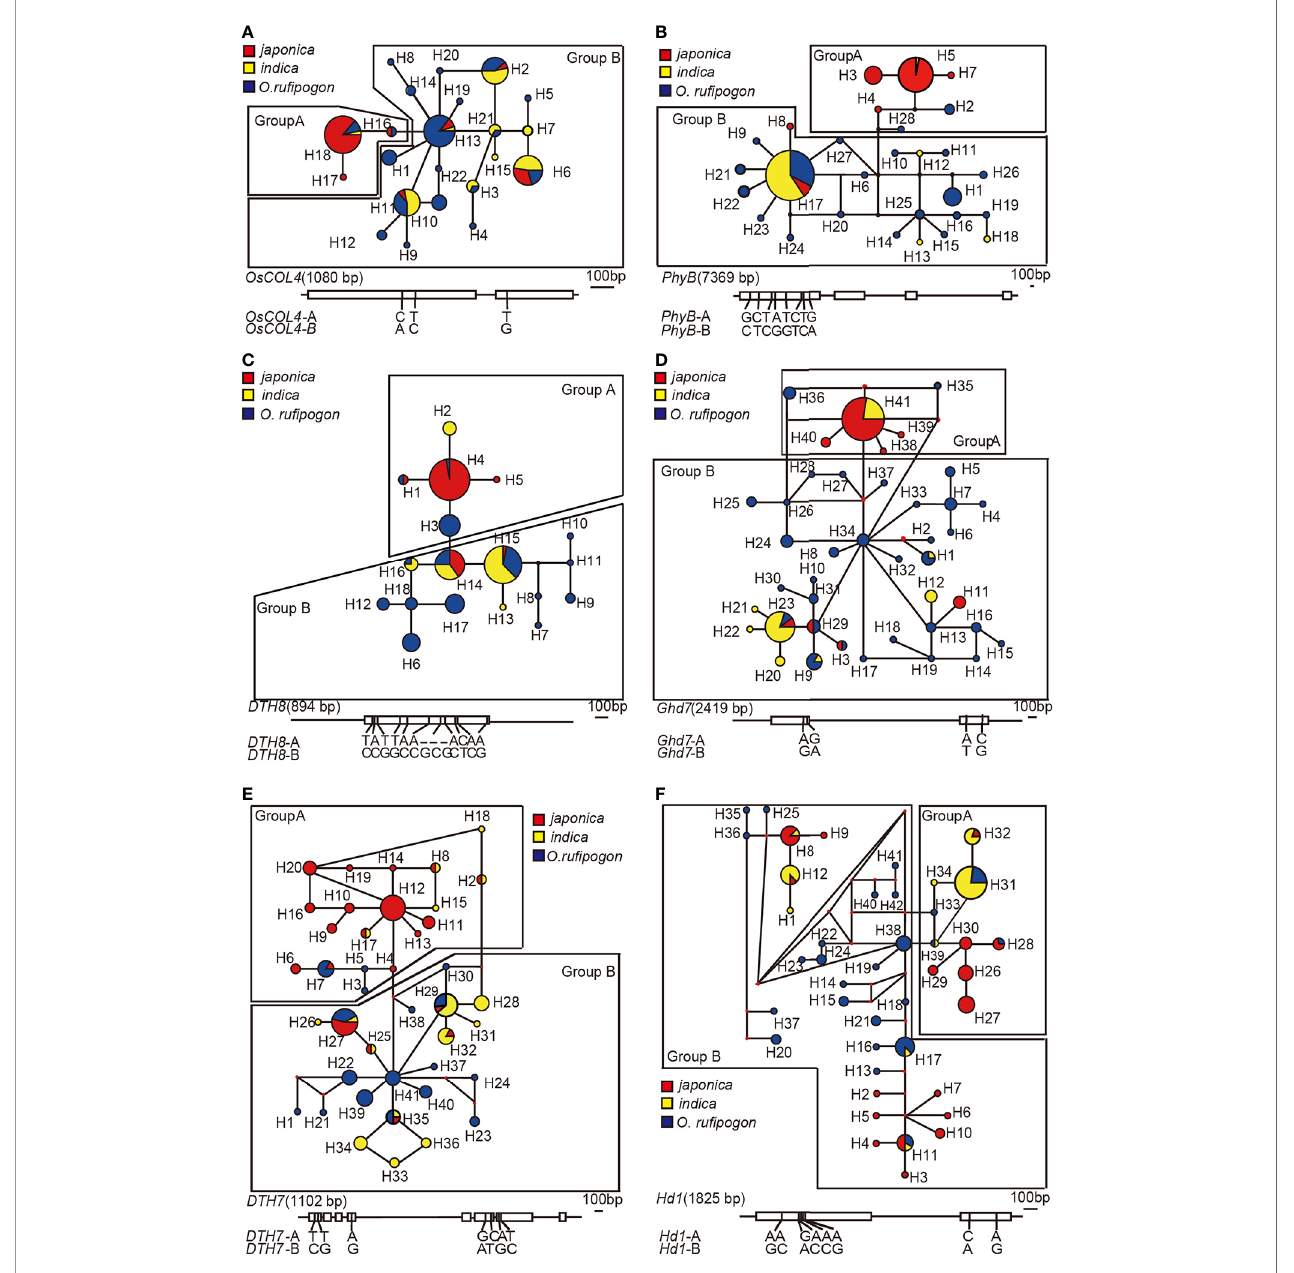
FIGURE 1 | Network trees of six long-day suppressor genes in cultivated rice. (A) OsCOL4 : H_2, H_6, H_11, H_13, and H_18 are high-frequency haplotypes of OsCOL4 . (B) PhyB : H _5 and H _17 are high-frequency haplotypes of PhyB . (C) DTH8 : H _3, H _4, H _6, H _14, H _15, and H _17 are high-frequency haplotypes of DTH8 . (D) Ghd7 : H _23 and H _41 are high-frequency haplotypes of Ghd7. (E) DTH7 : H _7, H _12, H _27, H _29, and H _32 are high-frequency haplotypes of DTH7. (F) Hd1 : H_8 , Hap_11, H_12, H_17, H_27 and H_31 are high-frequency haplotypes of Hd1. The size of the circle in each gene's network tree represents the haplotype frequency. Yellow and red represent the two subcultivars of cultivated rice, indica and japonica, and blue represents O.ru fi pogon . Each gene's network tree corresponds to the SNP on the diagram of long-day suppressor genes below, which illustrates the haplotype-speci fi c SNPs between group A and group B of the long-day suppressor